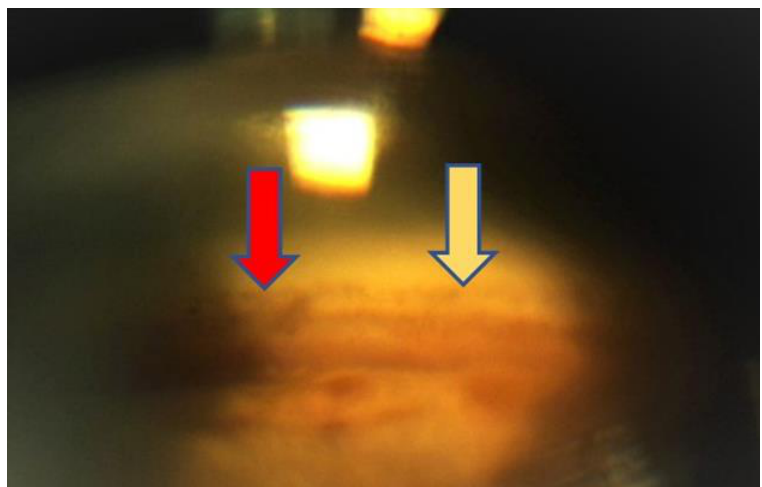
Figure 3. Gonioscopy view at 12 months. The area of ablation (yellow arrow) and the area of intact trabeculum (red arrow) are clearly visible.